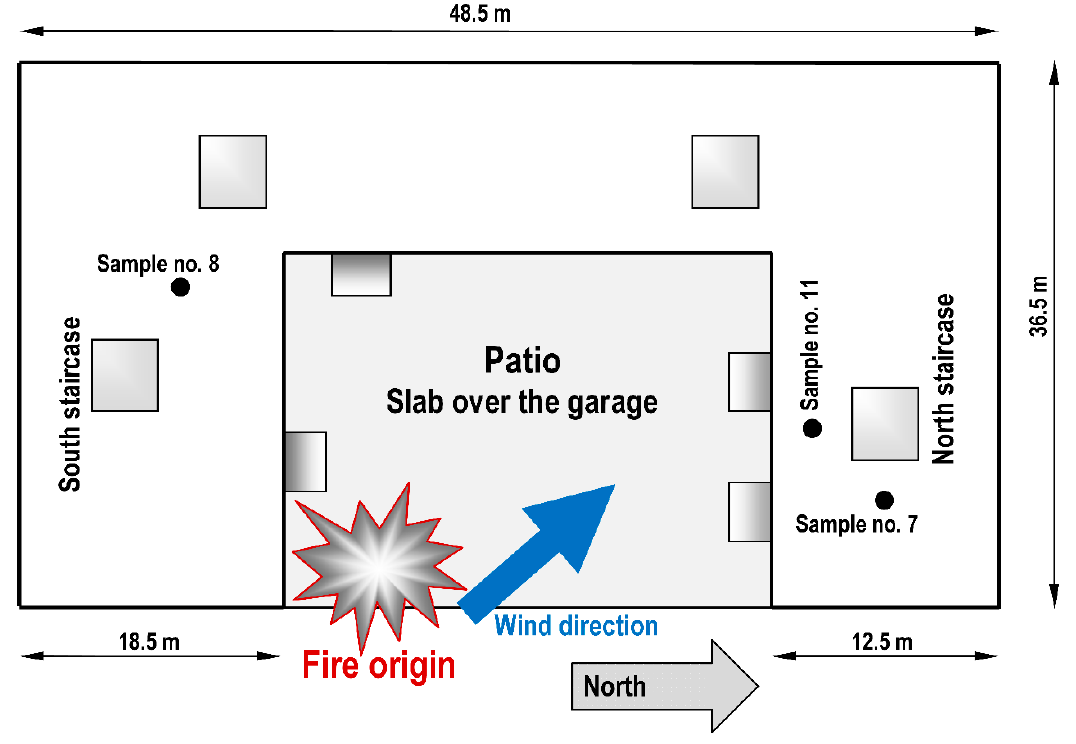
Figure 4. Diagram of the building damaged during the fire.